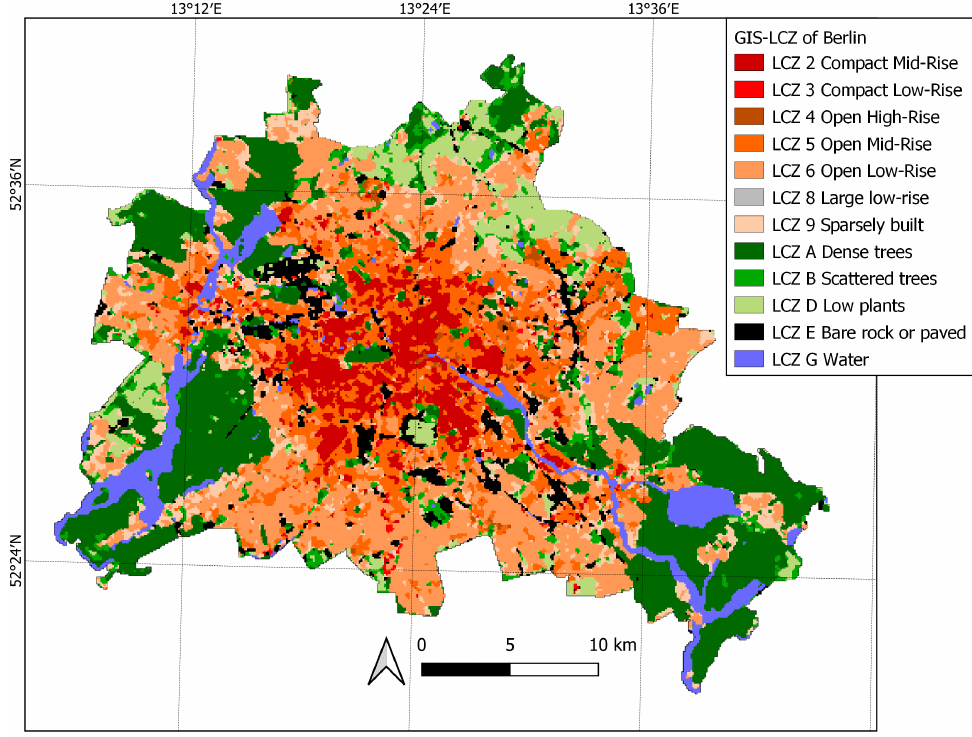
Figure 5. GIS-LCZ classification of